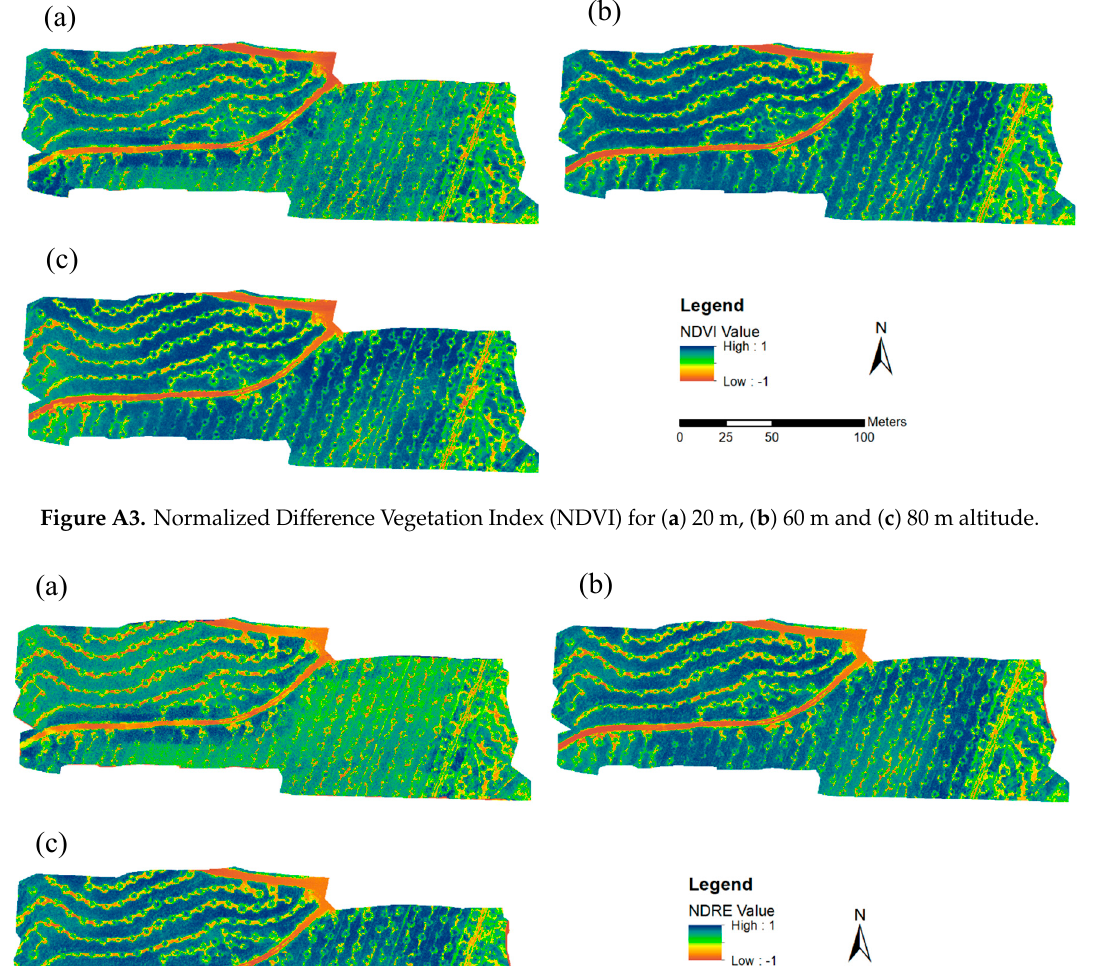
Remote Sens. 2020 , 11 , x FOR PEER REVIEW Figure A2. Digital Surface Model (DSM) of the AOI at UAV altitude of ( a ) 20 m, ( b ) 60 m and ( c ) 80 m.